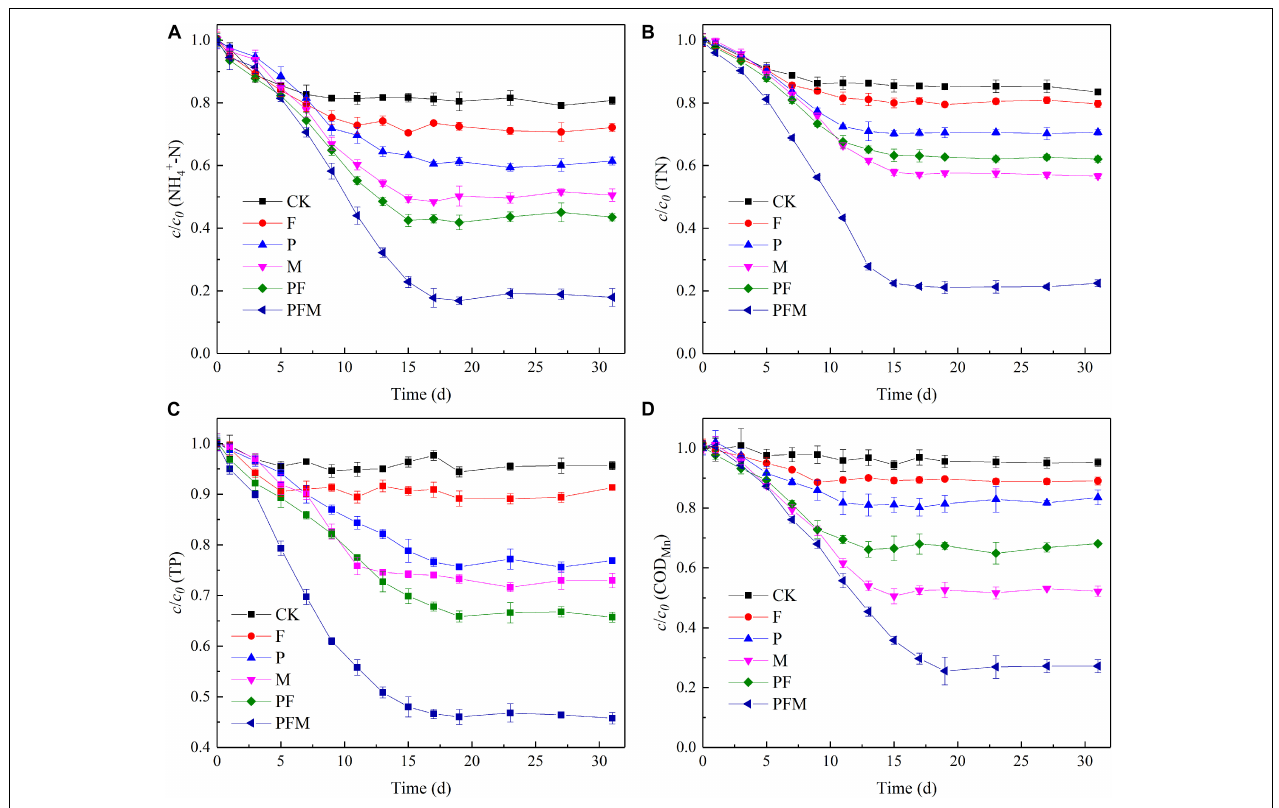
FIGURE 2 | Change of pollutants concentration in different floating beds. (A) NH 4 + -N. (B) TN. (C) TP. (D) COD Mn